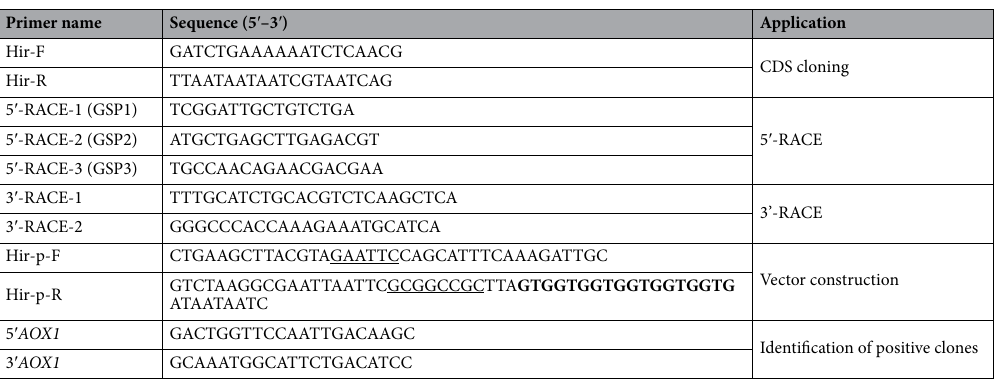
Table 1. Primers used in the present study. EcoRI (GAA TTC ) and NotI (GCG GCC GC) are underlined. The six-histidine tag sequence is in bold. CDS coding sequence, RACE rapid amplification of cDNA